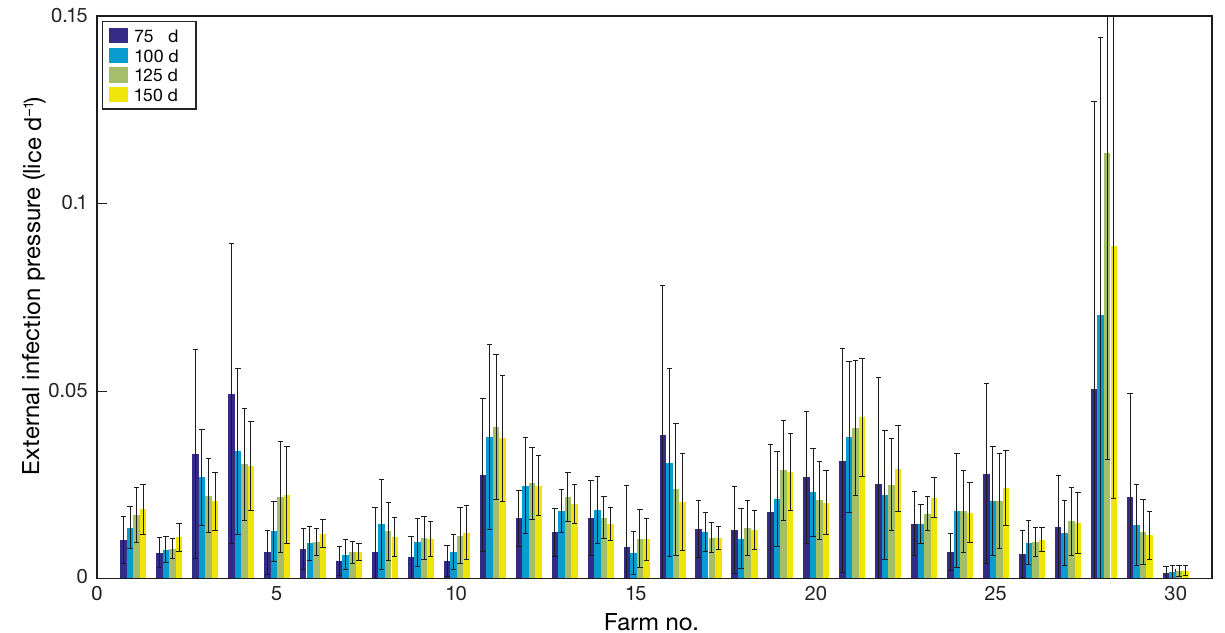
Fig. 3. Average external infection pressure including the first 75, 100, 125 and 150 d, with 95% CI error bars for each farm site in the Faroe Islands (n =